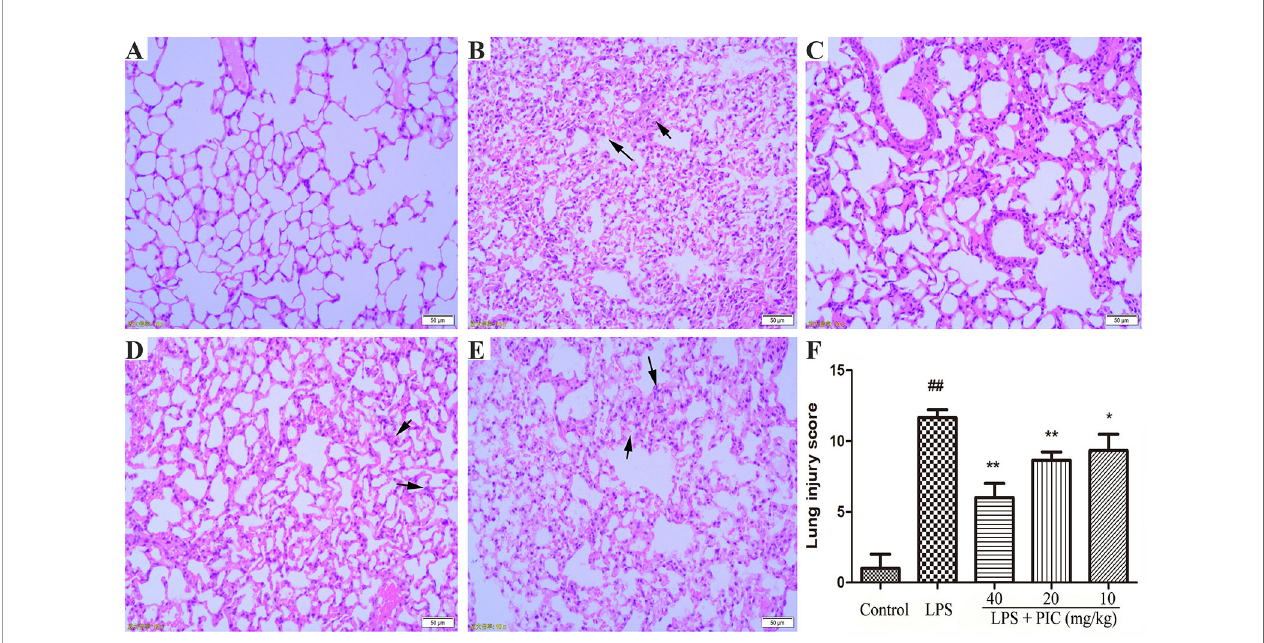
FIGURE 4 | The effect of piceatannol (PIC) on lung histopathology. The lung tissues of (A) control group, (B) lipopolysaccharide (LPS) group, and (C – E) PIC (40, 20, 10 mg/kg) groups were stained with hematoxylin and eosin (H & E) and detected under a light microscope. (F) Then lung tissue injury was scored by a blinded assessment method for fi ve categories. ## p < 0.01 is signi fi cantly different from the control group; ** p < 0.01 are signi fi cantly different from the lipopolysaccharide (LPS) group.